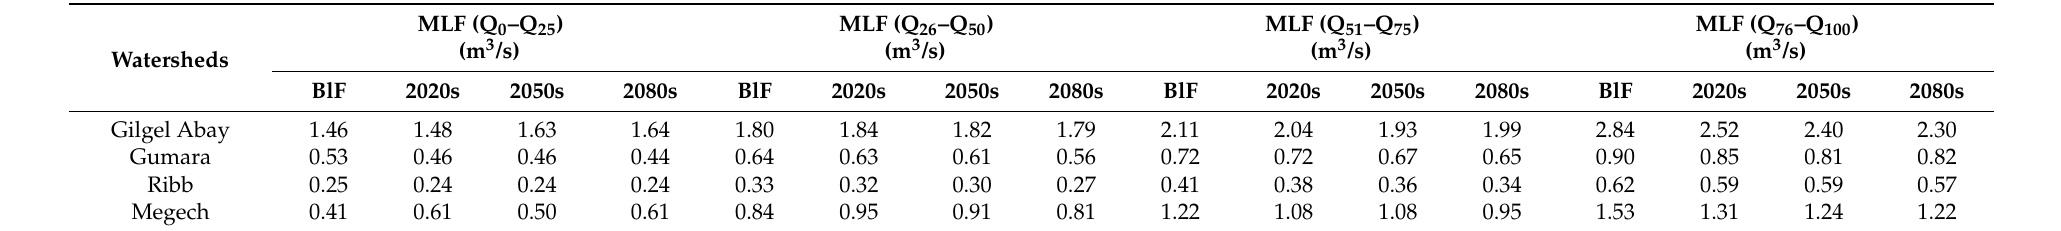
Table 7. The mean annual low flows of watersheds in the range of probability of non-exceedance in the ensemble mean of six climate models.